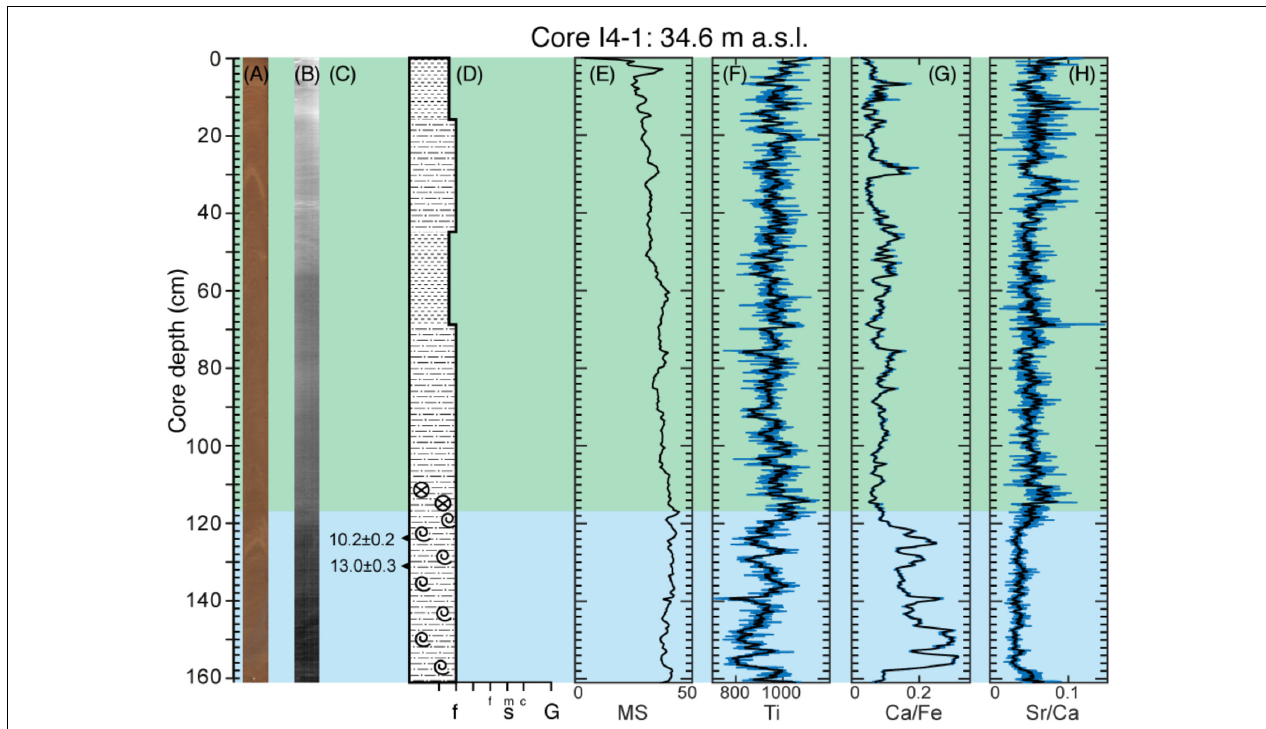
FIGURE 6 | Overview of Core I4-1. (A) High-resolution image of the core. (B) X-ray image. (C) Age and position of radiocarbon dates from foraminifera (black triangles). (D) Lithologic log with grain sizes from fines (clay, silt) to sand and gravel. (E–H) Magnetic susceptibility measurement and content of Ti; Ca to Fe ratio; Sr to Ca ratio. Blue background color indicates marine conditions, green indicates lacustrine. Refer to Figure 2 for